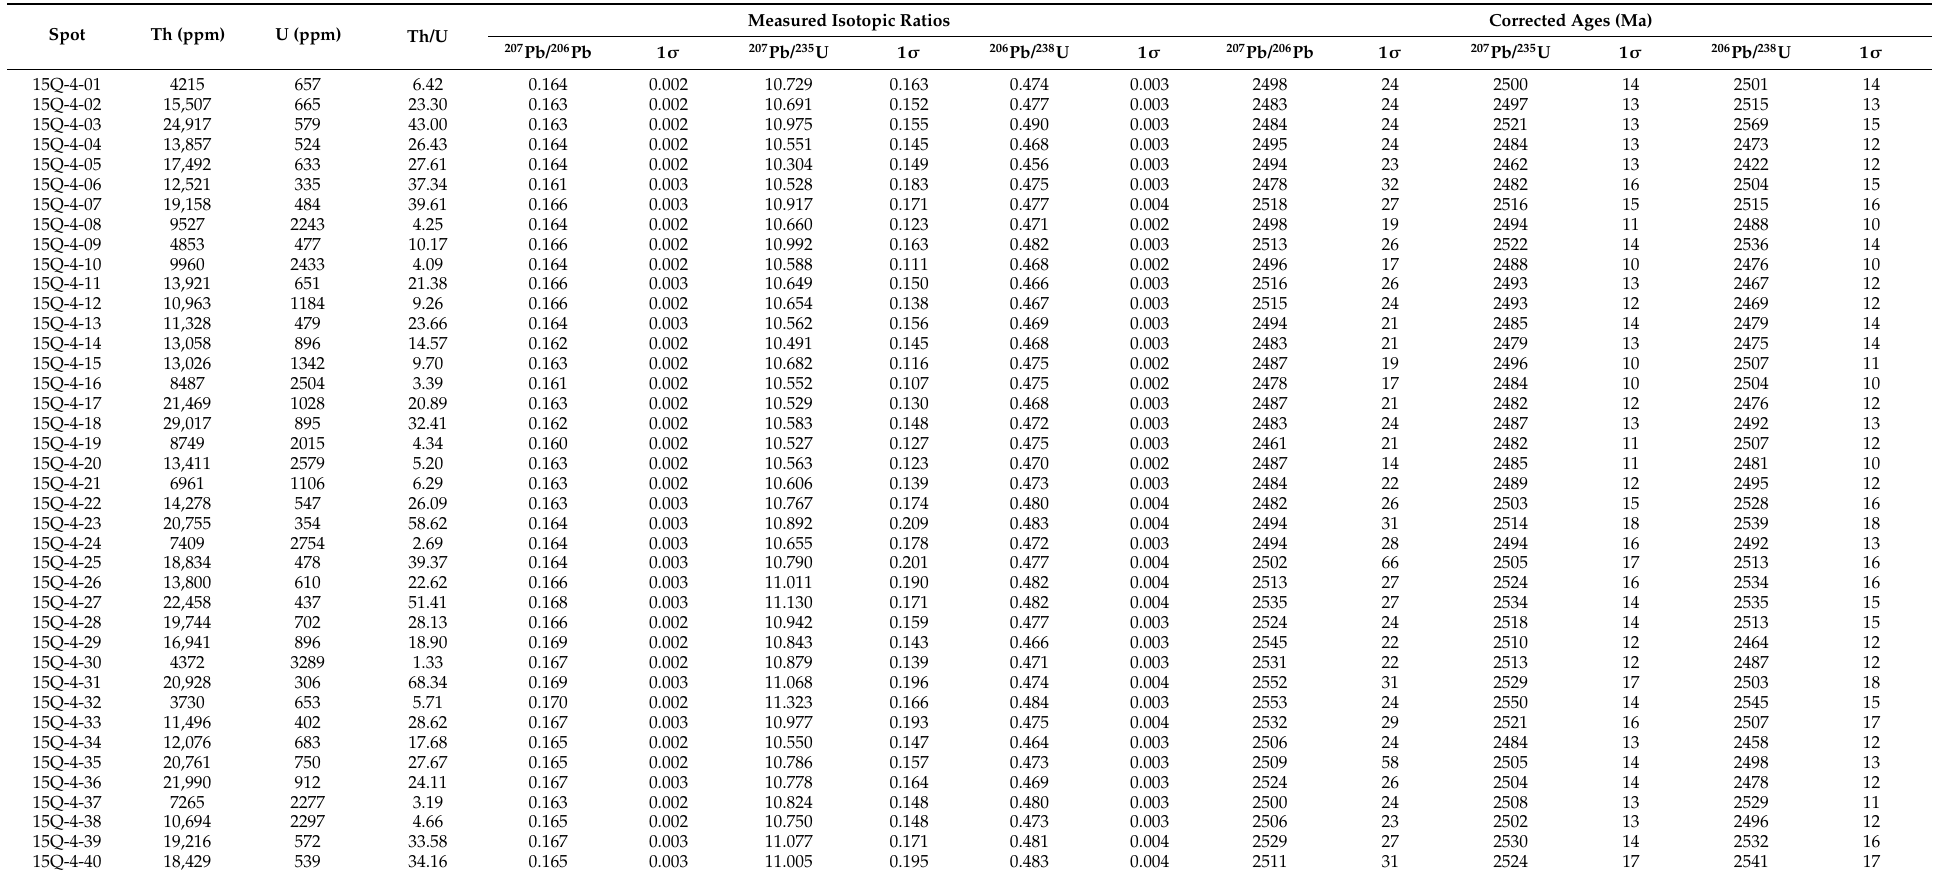
Table 2. Monazite isotopic data for sample